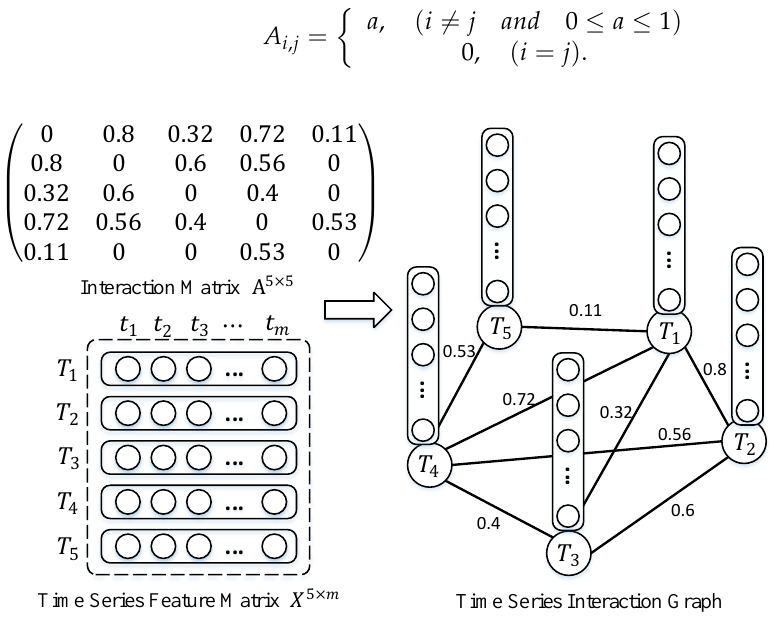
Figure 1. Time series interaction graph with five time